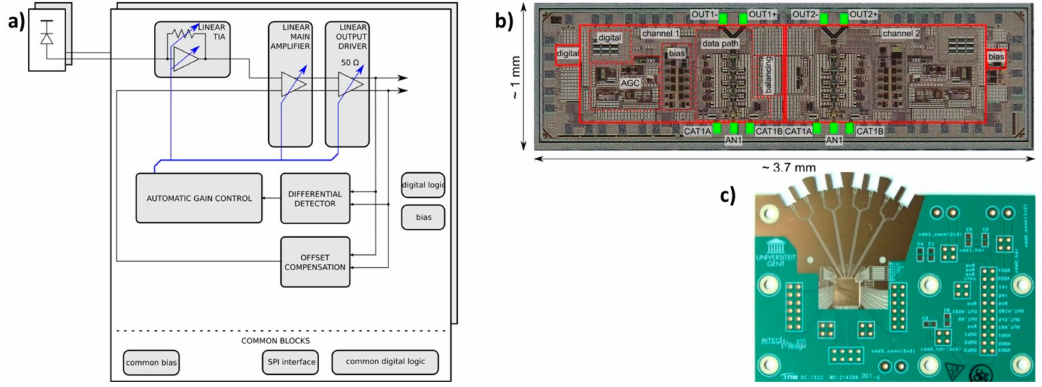
Figure 3. ( a ) Block diagram of a 2 × 1 TIA array, ( b ) micrograph of the TIA array die, ( c ) dual-channel receiver